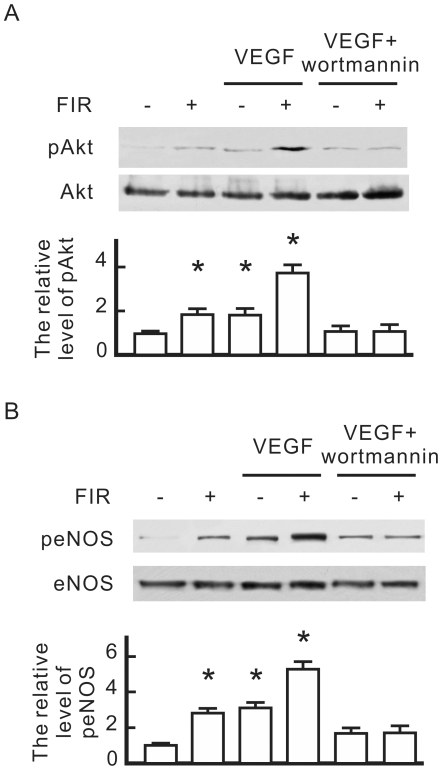
The influence of wortmannin on FIR-induced eNOS phosphorylation in HUVECs.HUVECs were pretreated with vascular endothelial growth factor (VEGF) (10 ng/ml), wortmannin (1 µM), or FIR exposure for 30 min as indicated, and then cultured for 1 h. (A) Western blotting of phospho-Akt. (B) Western blotting of phospho-eNOS. Akt and eNOS were detected as loading controls, and quantified phospho-eNOS and phospho-Akt expression relative to eNOS and Akt respectively. By comparison with the control without FIR exposure, relative levels of phospho-eNOS and phospho-Akt were obtained and are shown as the mean±S.D. from six determinations in three cell preparations. * p<0.05 vs. the control without FIR exposure.